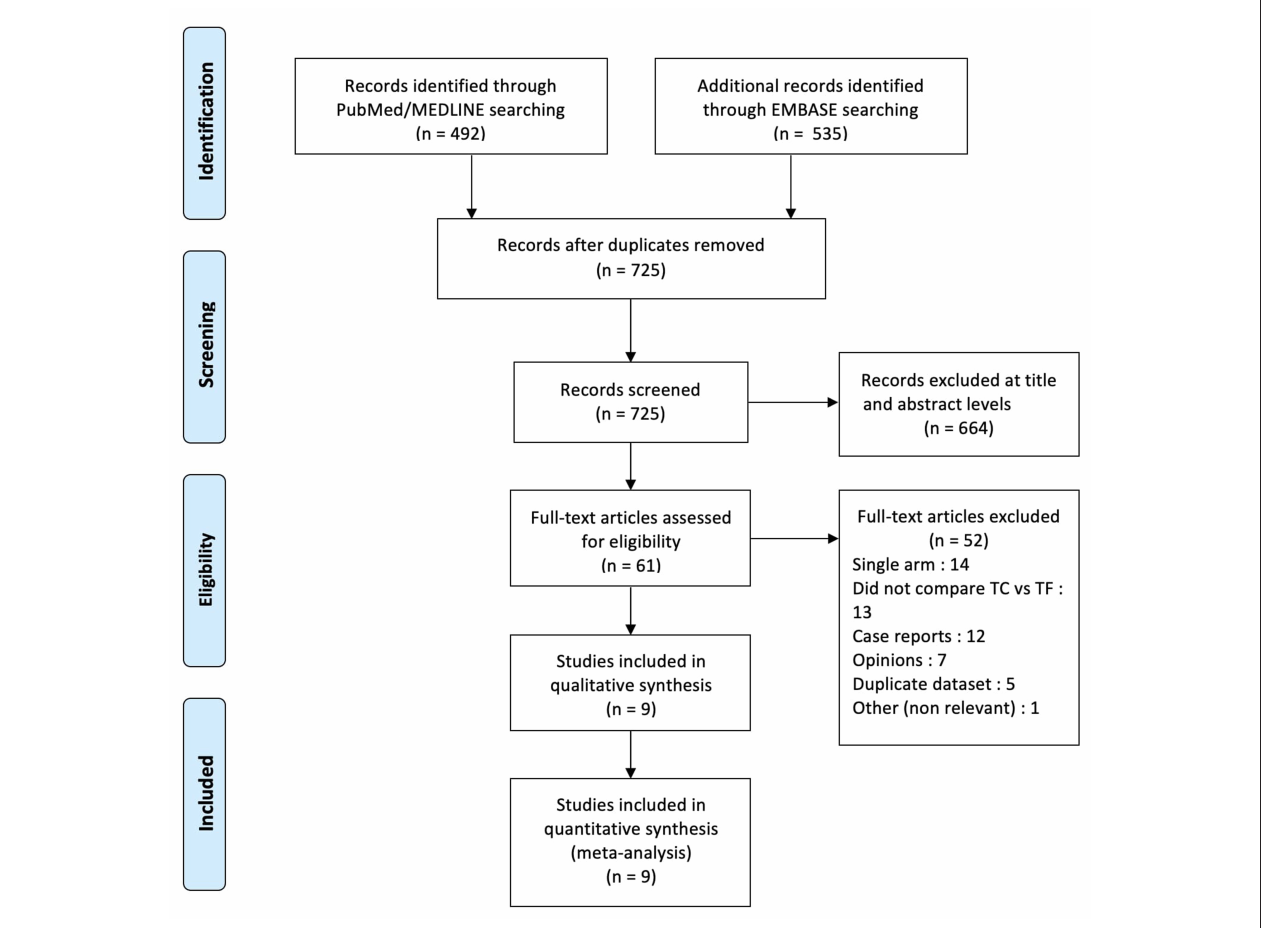
FIGURE 1 | PRISMA flow